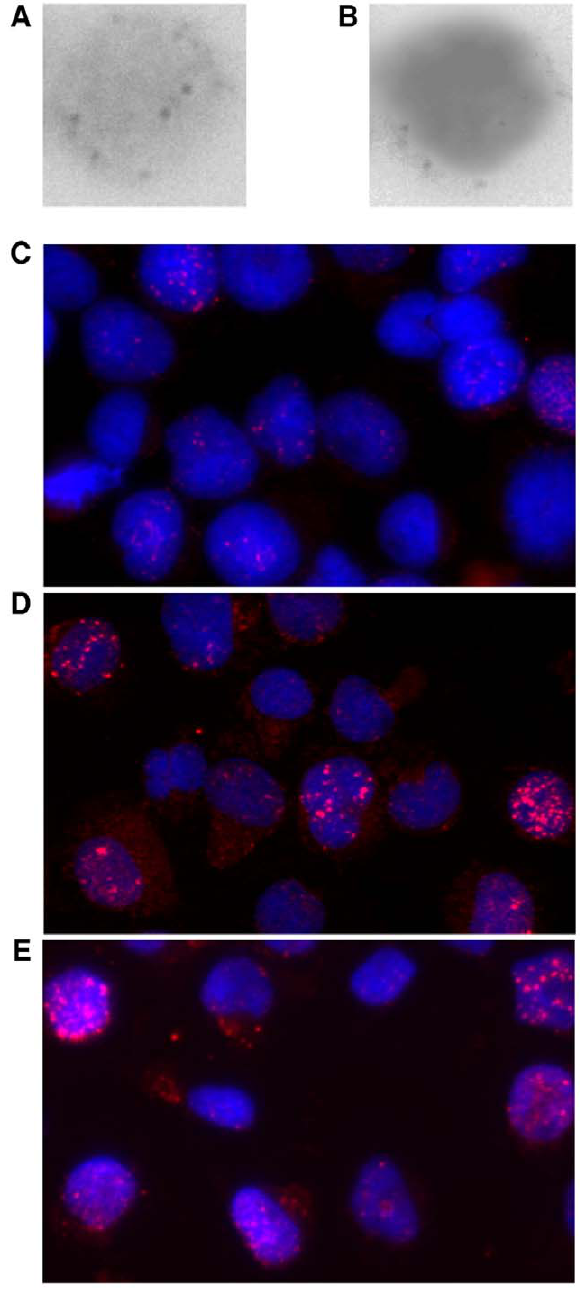
Figure 1. c -H2AX foci in human leukapheresis-derived mono- nuclear cells and transformed lymphocytes. ( A ) Human leuka- pheresis-derived mononuclear cells, stained for c -H2AX foci. Image post preset automated algorithm for image analysis using Adobe Photo- shop, version 7.0. Preset automated algorithm for image analysis consists of: ‘auto contrast,’ ‘auto levels,’ ‘desaturate,’ ‘invert.’ Without DAPI overlay, c -H2AX foci which fell within the area of the nucleus were easier to identify and count. ( B ) Human leukapheresis-derived mononuclear cells, stained for c -H2AX foci and overlaid with DAPI stained nuclear DNA antibody. Image post preset as described in Figure 1A. With DAPI overlay, c -H2AX foci were more difficult to identify and count. ( C–E ) c -H2AX foci in human transformed lymphocytes, Cytocentrifugation at various speeds before fixation. C. 200 rpm, D. 350 rpm, E. 500 rpm. Severity of DNA damage increases with higher G force settings.